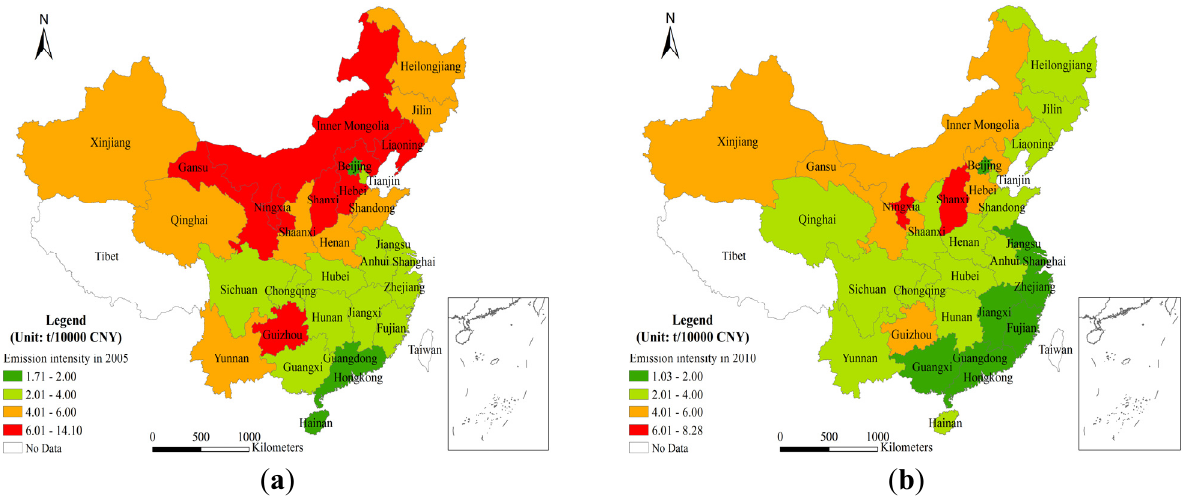
Figure 7. Provincial emission intensity distribution ( a ) Emission Intensity in 2005; and ( b ) Emission intensity in